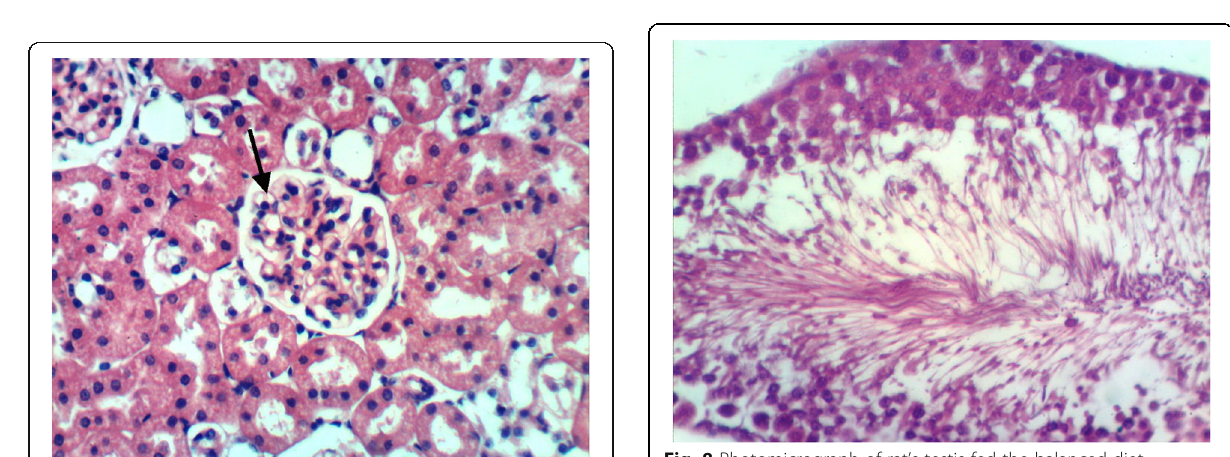
Fig. 8 Photomicrograph of rat ’ s testis fed the balanced diet supplemented with vanillin+ oral pot.bromate showing minor testicular damage with partial depletion of germ cells (H&E ×